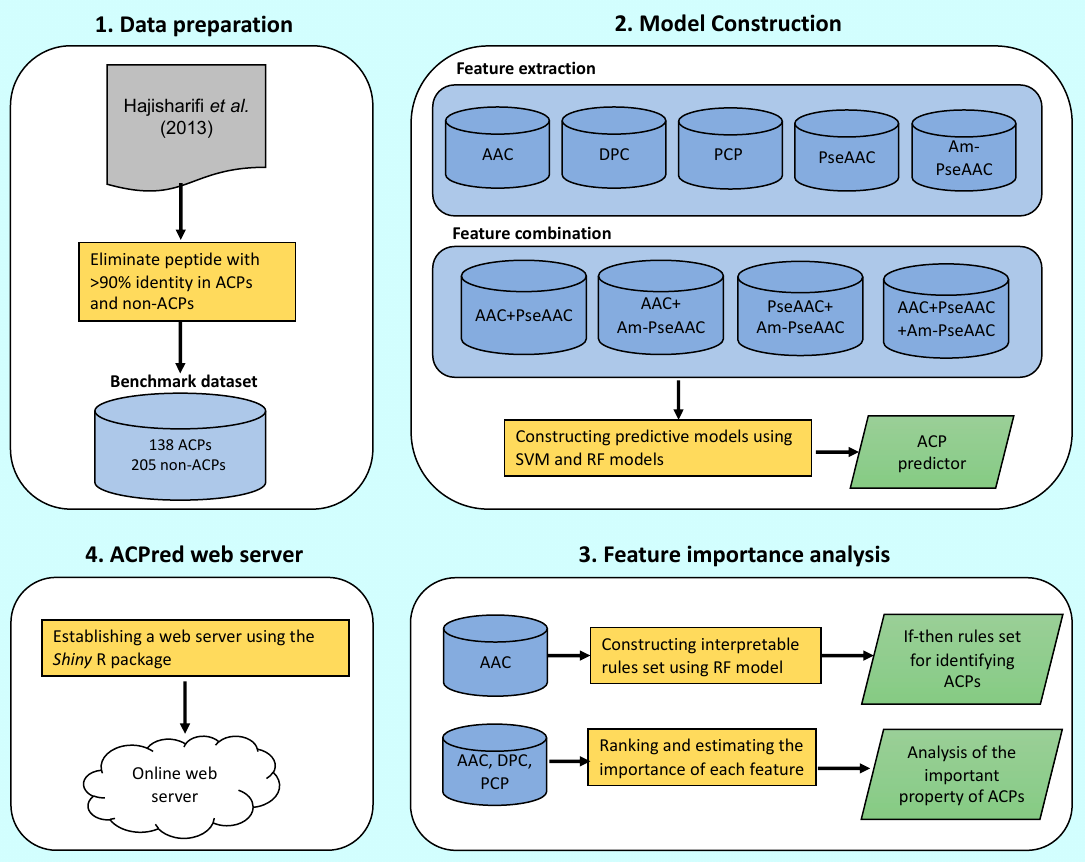
Figure 2. Schematic framework of ACPred.